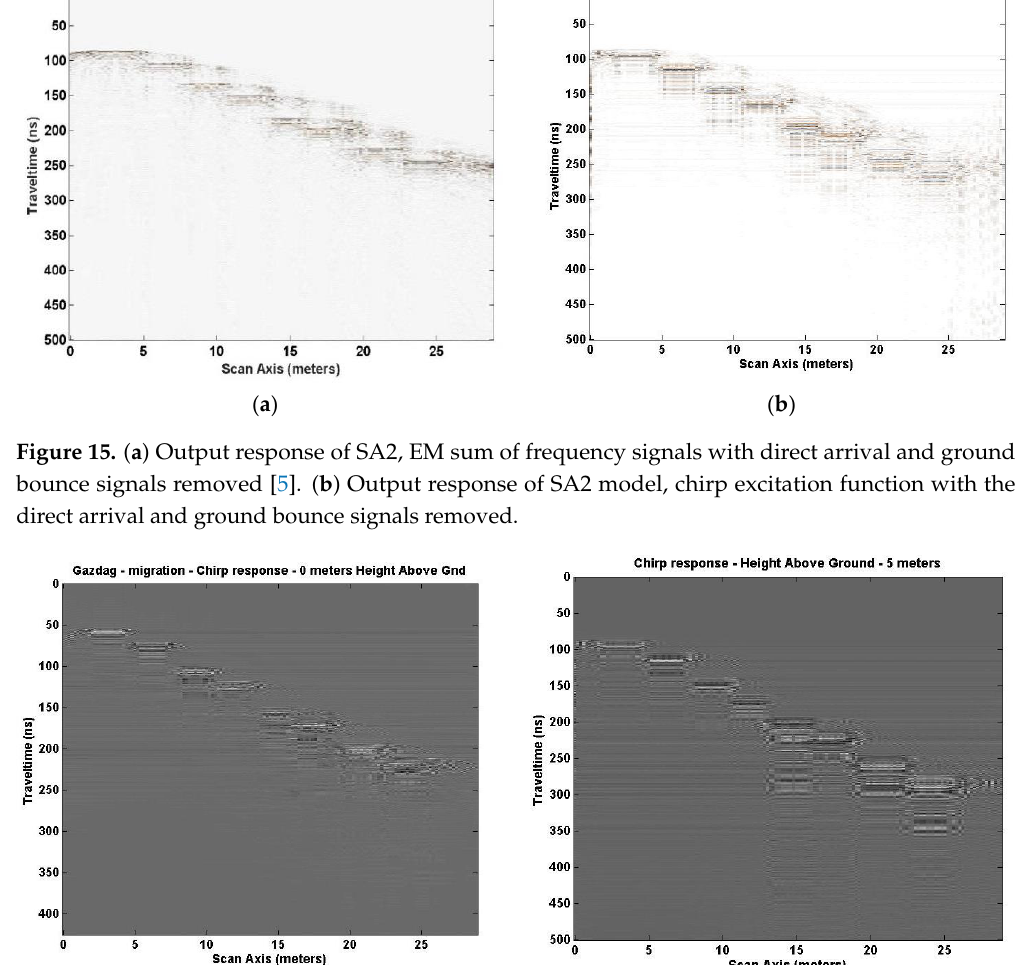
Figure 14. Defined space SA2, with (8) 2-m-long plates, 0.1 m thick at nearly 5, 6, 9, 10, 13, 14, 17, and 18 m with Tx/Rx pair 5 m above ground [5].